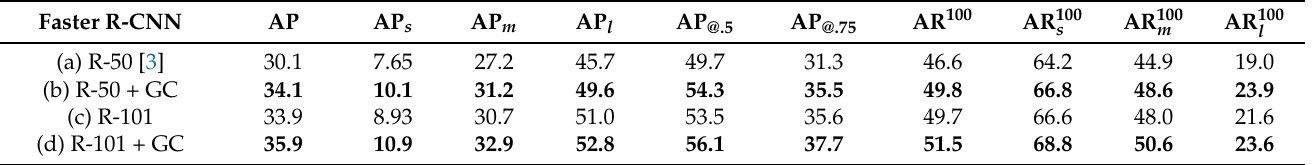
Table 1. Object detection results using Faster R-CNN [7] on the COCO val2017 dataset. Here ResNet is abbreviated as “R”. Incorporating global contexts (GC) improves the quality of object detection in all metrics. The number in bold means superiority compared to that of the baseline in the metric.